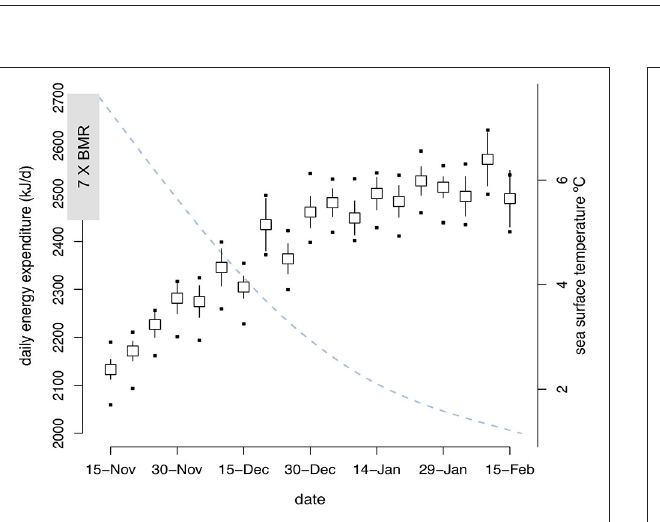
FIGURE 2 | Mean ( ± SE) daily energy expenditure (DEE) of murres ( n = 8) over winter (15-Nov − 15 Feb) averaged over 5-day intervals. The dotted blue line shows associated daily sea surface temperature (from generalized additive mixed model output). Black symbols indicate estimated DEE using minimum and maximum time spent resting (on the water) scenarios.